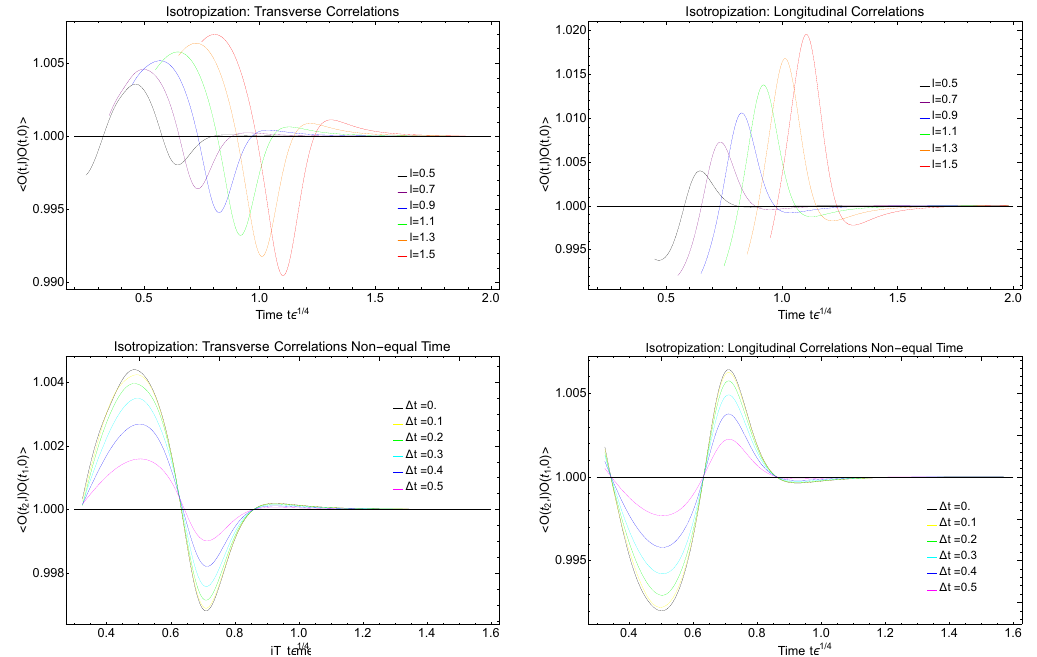
Figure 9 . 2-point correlation functions of an (uncharged) scalar operator in a thermalizing (cid:13)uid (dual to evolution towards a Schwarzschild black brane geometry), (cid:26) = 0, B = 0, case (a) in (cid:12)gure 1. Top Left: lengths in the transverse direction at (cid:1) t = 0. Top right: lengths in the longitudinal direction at (cid:1) t = 0. Bottom left: transverse length separation by l = 0 : 65 at various time separations (cid:1) t . Bottom Right: longitudinal length separation by l = 0 : 65 at various